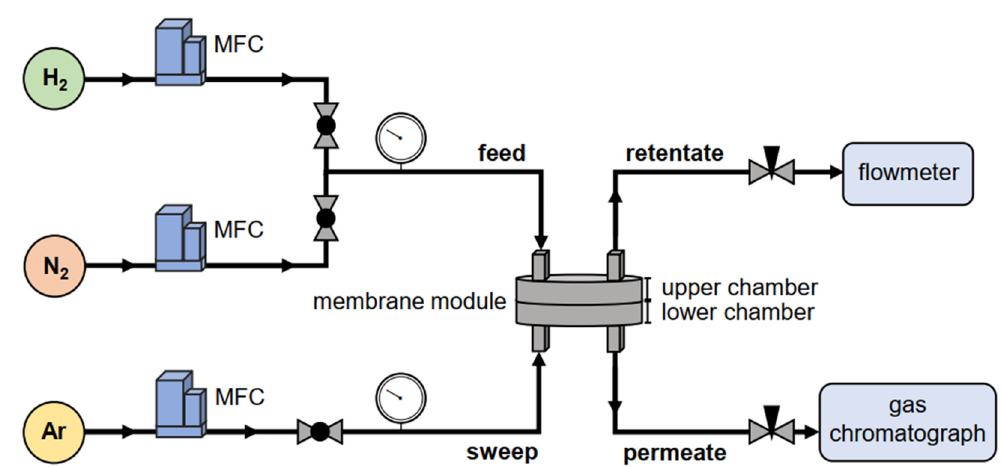
Figure 2. Scheme of the Wicke–Kallenbach apparatus used in gas separation experiments. It consists of two inlets (feed and sweep flows), two outlets (retentate and permeate flows), three mass flow controllers (MFCs), two needle valves, a flowmeter, and a gas chromatograph. The sample is placed between the upper and lower chambers of the membrane module.